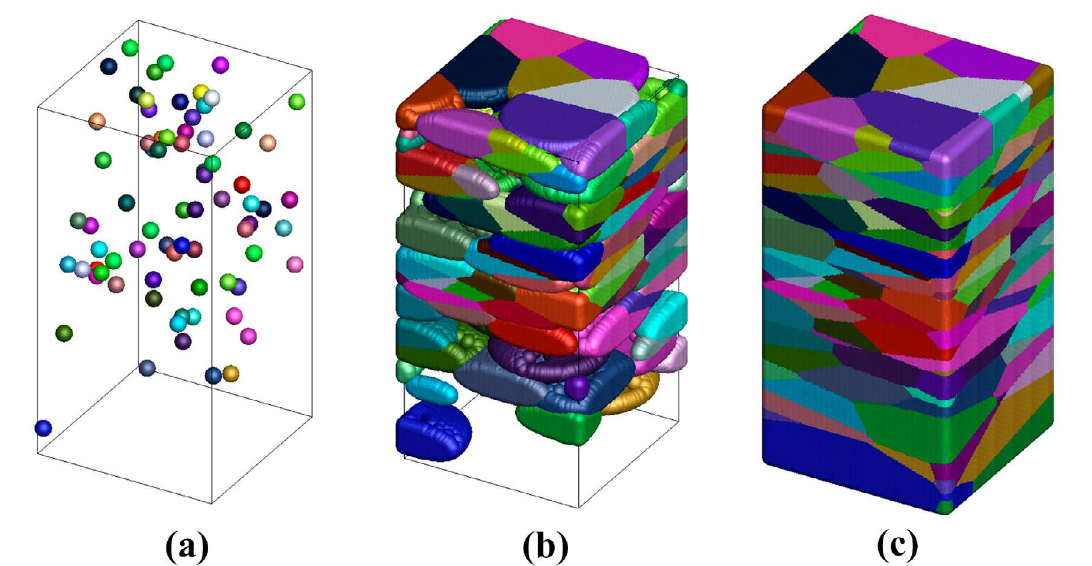
Figure 1. Computer simulated microstructures of the transformations inhomogeneous nucleated with grains that grow as oblate spheroids with aspect ratios 4:4:1: (a) V